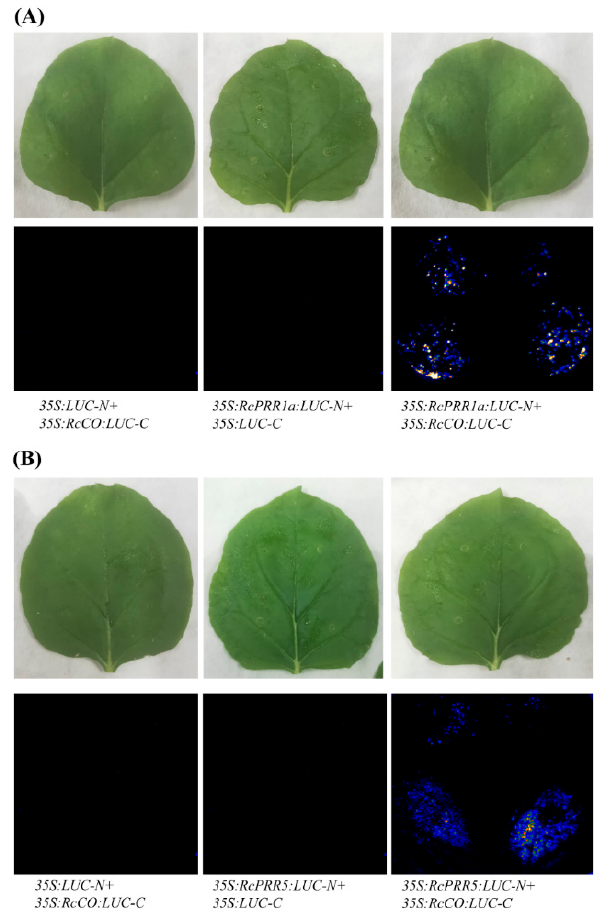
Figure 9. The protein-to-protein interactions of RcPRR1a and RcPRR5 with RcCO in Nicotiana benthamiana leaves. ( A ) 35:LUC-N+35:RcCO:LUC-C and 35:RcPRR1a:LUC-N+35:RcCO:LUC-C represent the interaction of LUC with RcCO and RcPRR1a, respectively, while 35:RcPRR1a:LUC- N+35:RcCO:LUC-C represent the interaction RcPRR1a with RcCO ( B ) 35:LUC-N+35:RcCO:LUC-C and 35:RcPRR5:LUC-N+35:RcCO:LUC-C represent the interaction of LUC with RcCO and RcPRR5 , respectively, while 35:RcPRR5:LUC-N+35:RcCO:LUC-C represent the interaction RcPRR5 with RcCO .